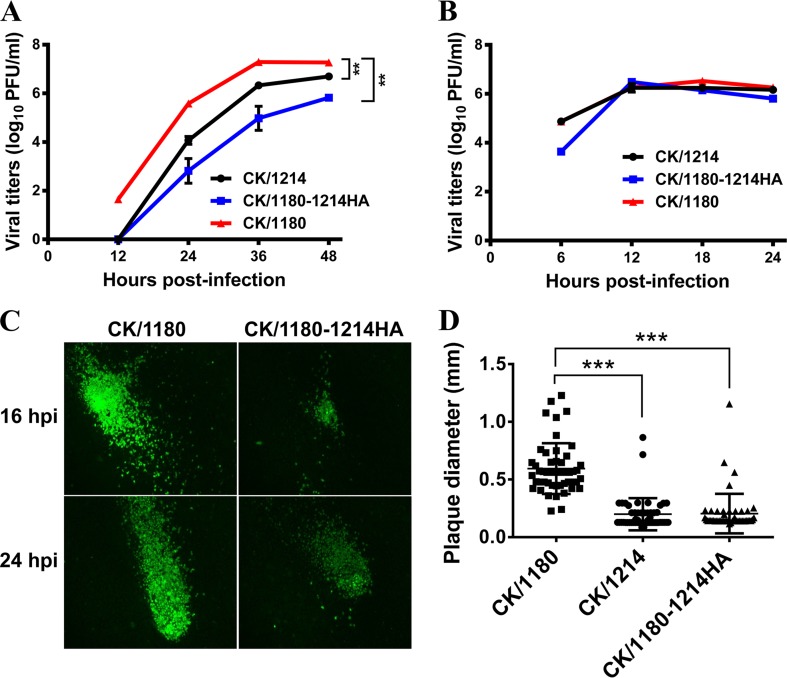
Growth kinetics of viruses in MDCK cells. Growth curves of CK/1180, CK/1214, and CK/1180-1214HA in MDCK cells infected at multiplicities of infection (MOI) of 0.001 (A) and 5 (B) are shown. Viruses were inoculated into MDCK cells. At the indicated times after infection, virus titers in the supernatant were determined by means of plaque assays. The reported values are means ± SD from two independent experiments. **, P < 0.01 (multiple t tests in GraphPad Prism 6). (C) Viruses were inoculated into MDCK cells at an MOI of 0.001. At the indicated times after infection, the cells were fixed with 4% paraformaldehyde in PBS and then analyzed with an anti-HA antibody in an immunofluorescence assay. (D) Plaque diameters of CK/1180, CK/1214, and CK/1180-1214HA viruses in MDCK cells. Plaque assays were produced under standard conditions and stained with 0.1% crystal violet. The diameters of 50 random plaques were measured for each virus. ***, P < 0.001 (Student's t test).